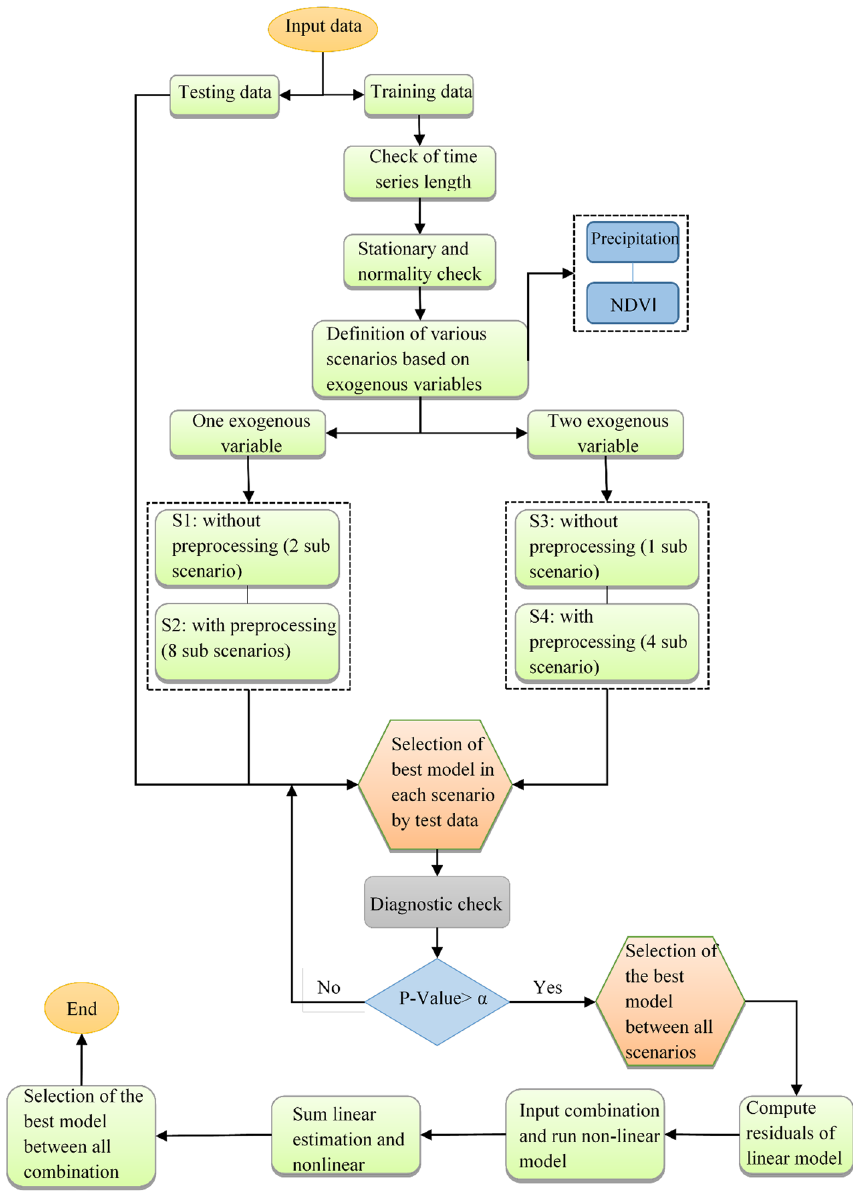
Fig. 3 Flowchart of the pro- posed methodology for runoff modeling in